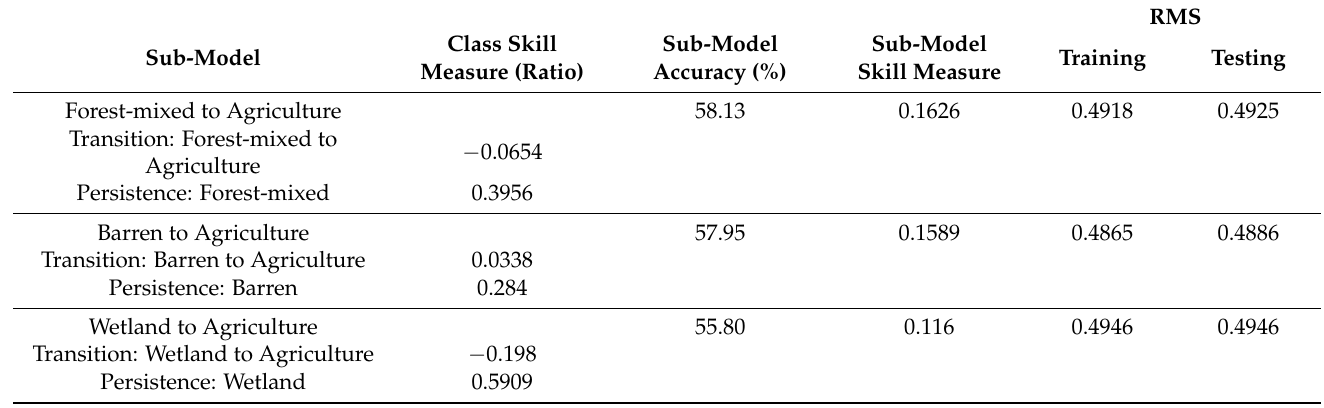
Table 8. Sub models in the Multi-Layer Perceptron (MLP) using the six explanatory variables and model performance summary for Dedza district